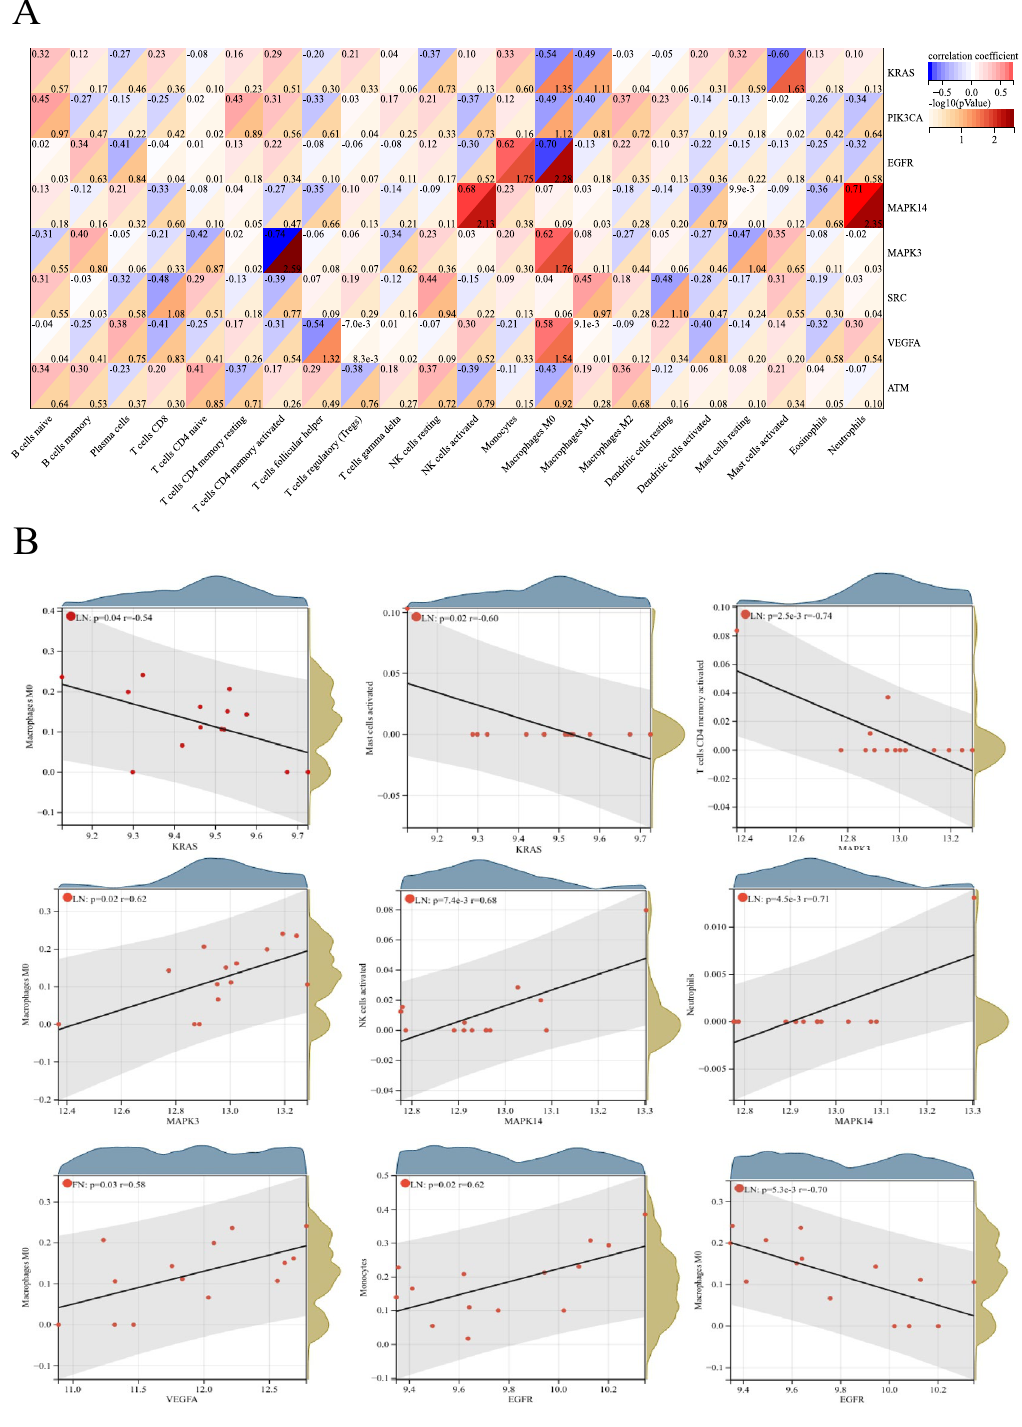
Figure 7. Correlation between hub LN-FRGs and immune-infiltrated cells in LN. ( A )The darker is the red hue, the smaller is the P value. ( B )The correlation analysis of hub LN-FRGs and immune-infiltrated cells, P <